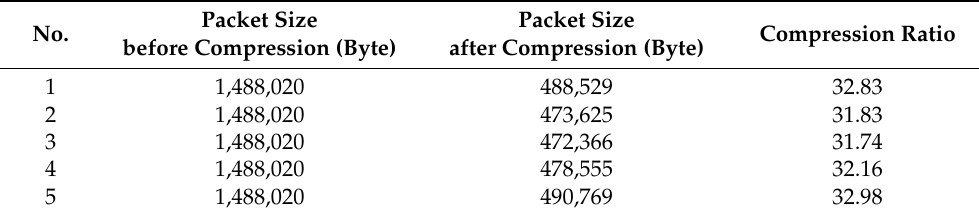
Table 2. The compression ratio of Zlib.